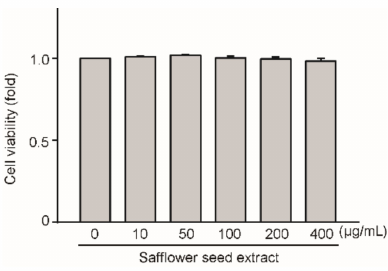
Figure 1. Toxicity of safflower seed extract against chondrocytes. The toxicity of safflower seed extract against chondrocytes was measured using the LDH assay at concentrations of 0, 10, 50, 100, 200, and 400 µ g/mL for 24